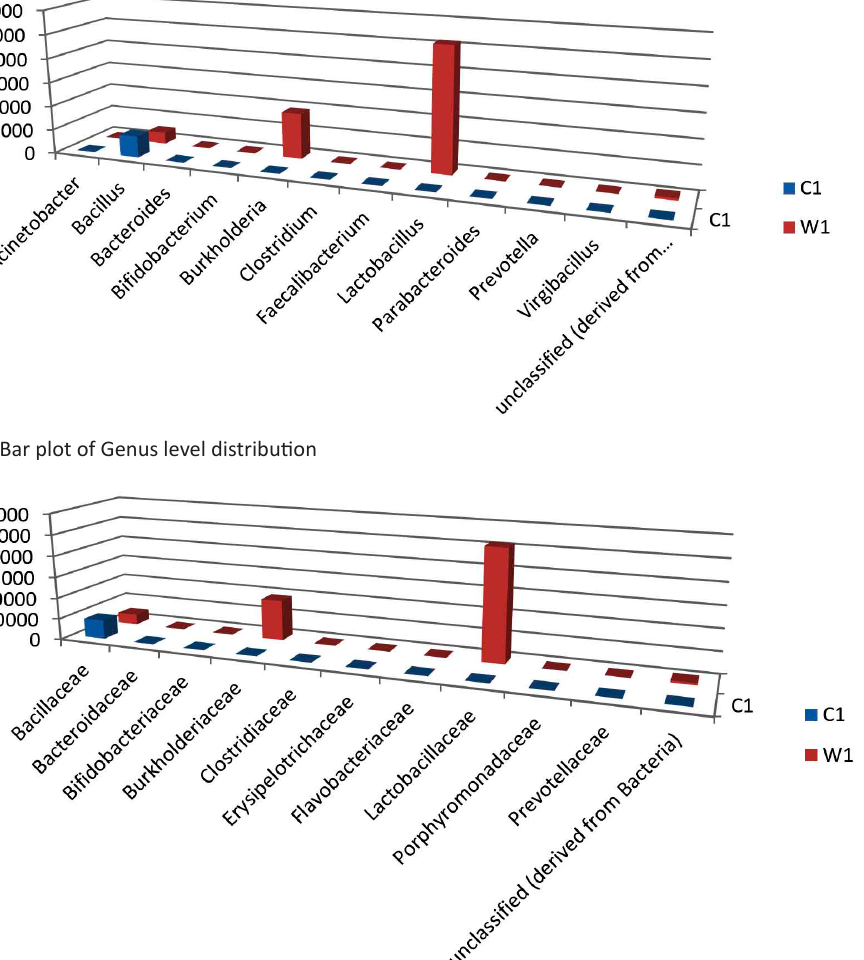
Fig. 5. Bar plot of Family level